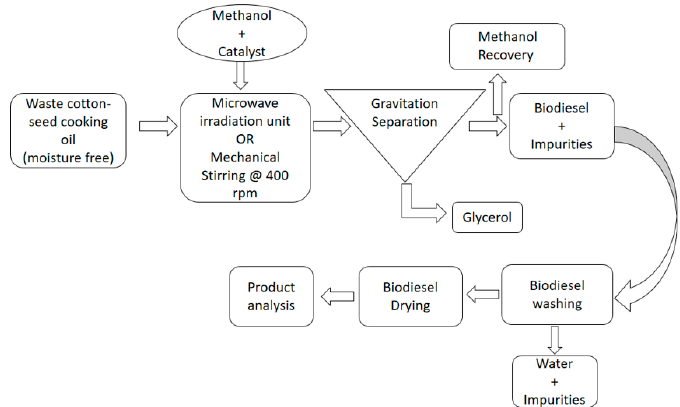
Figure 6. MW-assisted biodiesel production process with either CaO or KOH as the catalyst [41]. An RSM-based design-of-experiments (DOE) approach was used to optimise the reaction conditions: Methanol/oil ratio, catalyst loading and reaction time. Furthermore, the activation energies of the different catalysts were estimated by running the reaction at different temperatures; 45, 50 and 55 °C. As expected, KOH is more active, with an activation energy of 13.05 kJ/mol versus 28.93 kJ/mol for CaO. However, it was noted that both materials were efficiently activated by MW